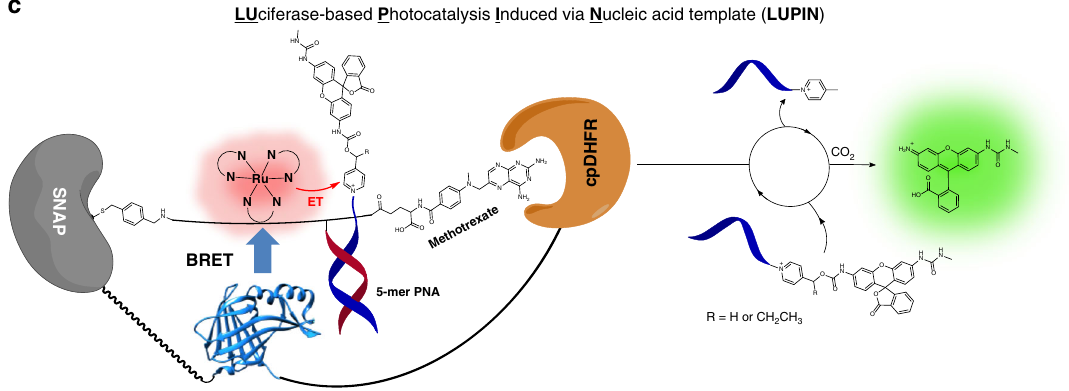
Fig. 1 Concept and design of LUPIN. a The emission spectrum of NLuc (blue) overlaps very well with the absorption spectrum of the ruthenium photocatalyst (red), suggesting that ef fi cient BRET should be possible. b The fusion protein SNAP-Pro30-NanoLuc (NLuc)-cpDHFR is linked via self- labeling SNAP to the synthetic linker containing the ruthenium photocatalyst and methotrexate (purple ball, DHFR ligand), positioning the ruthenium in close proximity to the NLuc. Free methotrexate (green ball) can push the sensor into the open conformation, thus turning off the BRET to the photocatalyst. c By installing a PNA next to the ruthenium catalyst, complementary pyridinium substrates can bind and undergo photoreductive cleavage by the ruthenium, unmasking the effector